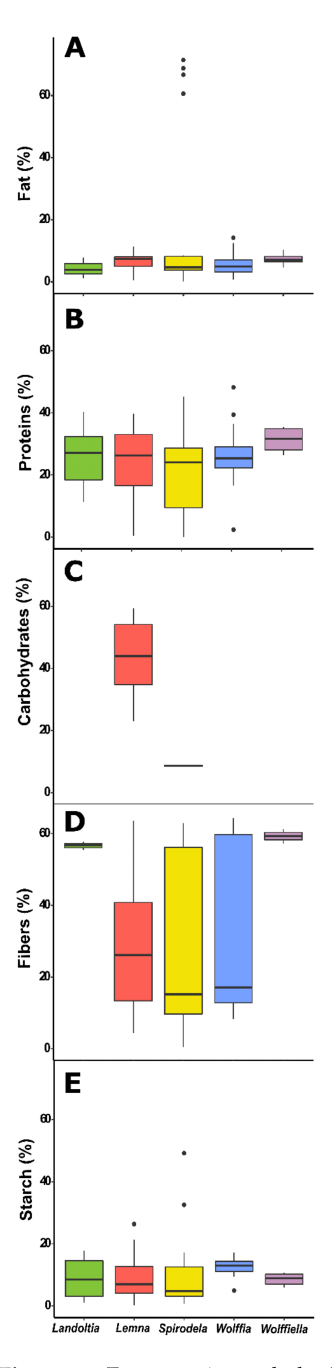
Figure 3. Fat, protein, carbohydrate, and fiber contents in duckweeds. ( A ) Fat (%) variability among the duckweed genera. ( B ) Proteins levels (%) variability in duckweeds. ( C ) Fibers (%) content. ( D ) Carbohydrates (%) variability in duckweed genera. ( E ) Starch (%) levels among duckweed